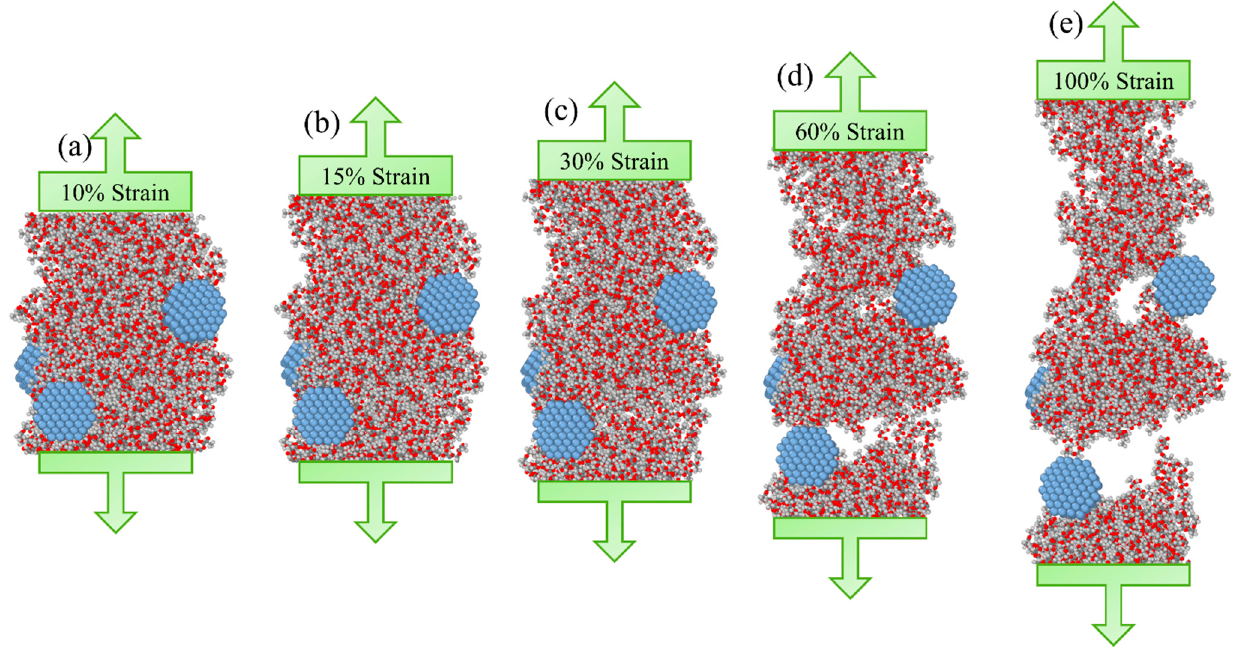
Figure 4. Tensile deformation on the nanofibre doped with 5.8% weight fraction of silver nanoparticles. ( a ) at 10% strain and in the elastic phase ( b ) at 15% strain and in the strain-softening phase due to the chain slippage ( c ) at 30% strain slightly after crack initiation ( d ) at 60% strain and the crack propagation phase due to pulling out of polymer chains ( e ) at 100% strain and close to complete rapture.